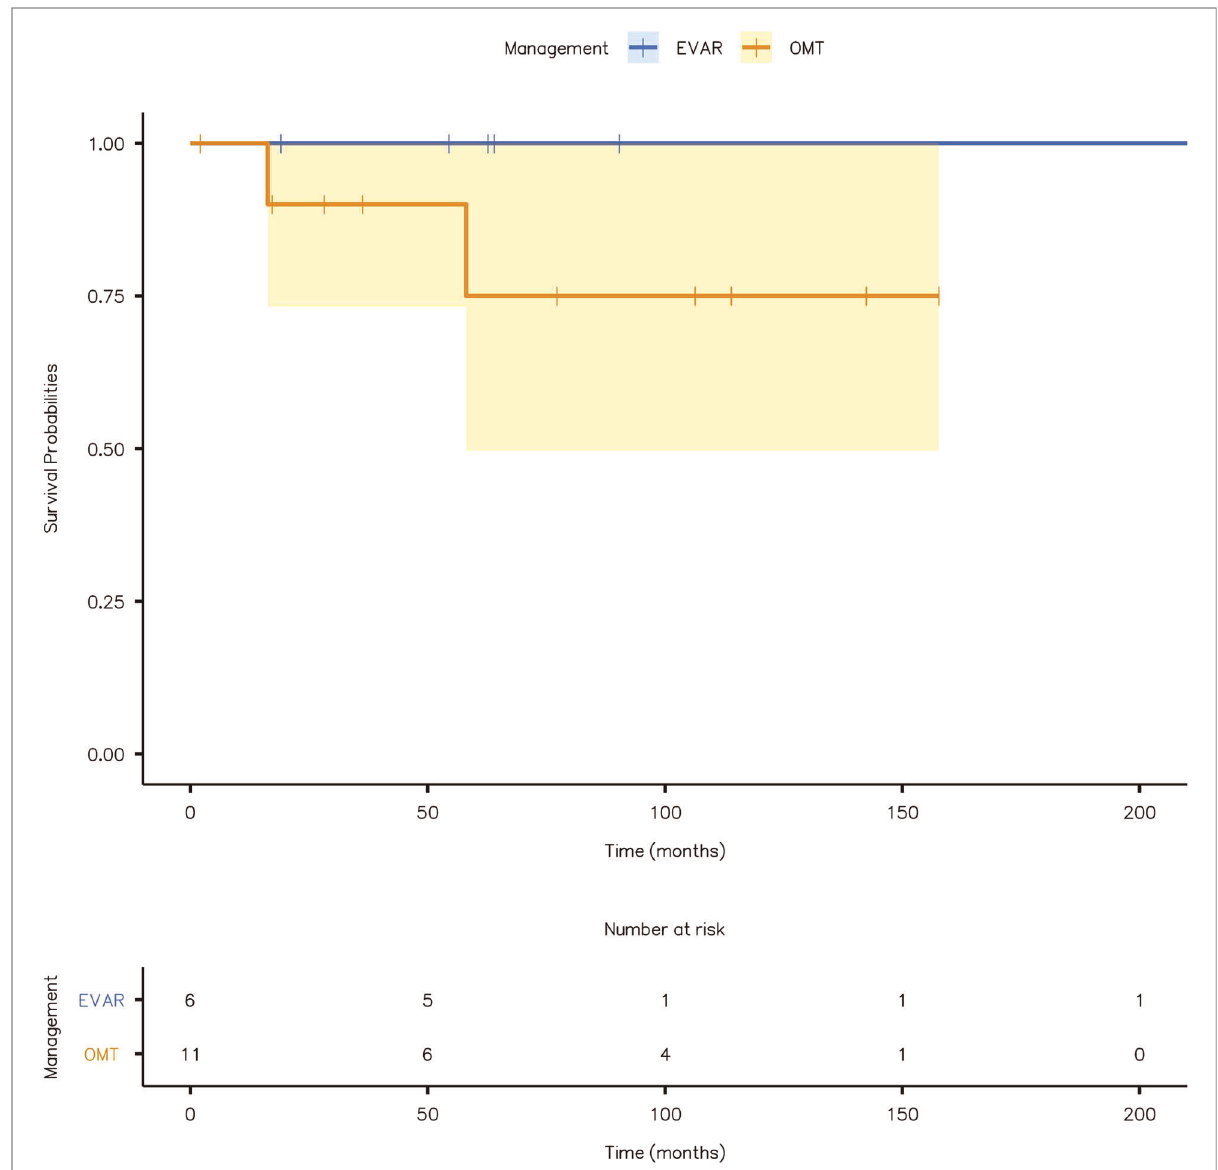
FIGURE 6 Kaplan-Meier plot showing all-cause mortality in patients with optimal medical therapy (OMT) and endovascular aneurysm repair